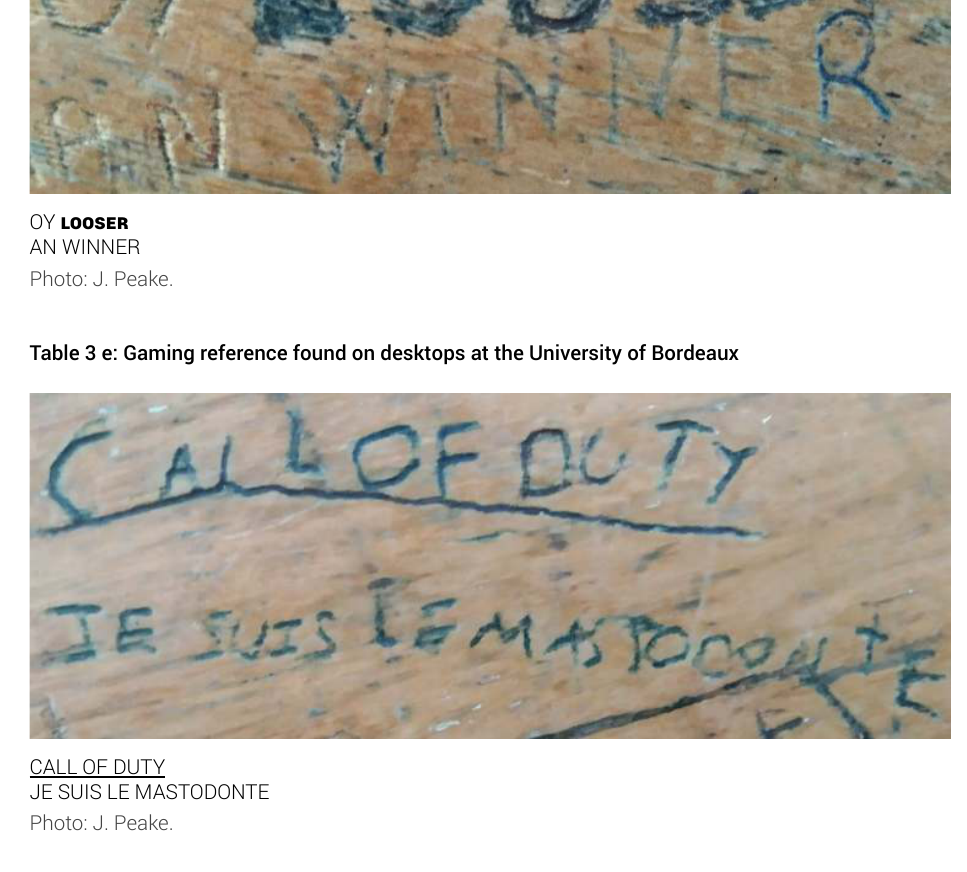
Table 3 f: Gaming reference found on desktops at the University of Bordeaux